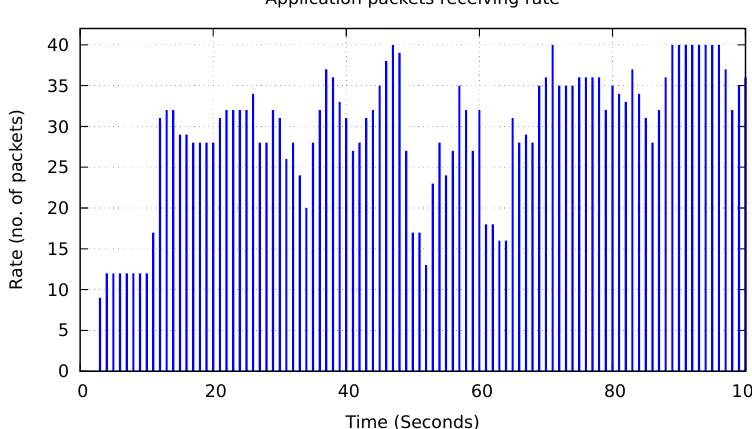
Figure 7. Application packets receiving rate.